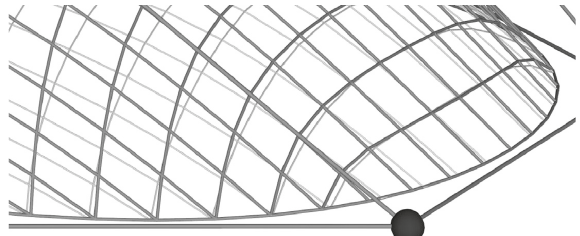
Figure 19: Boundary alignment of the resultant thrust network (lighter) based on the initial network (darker).